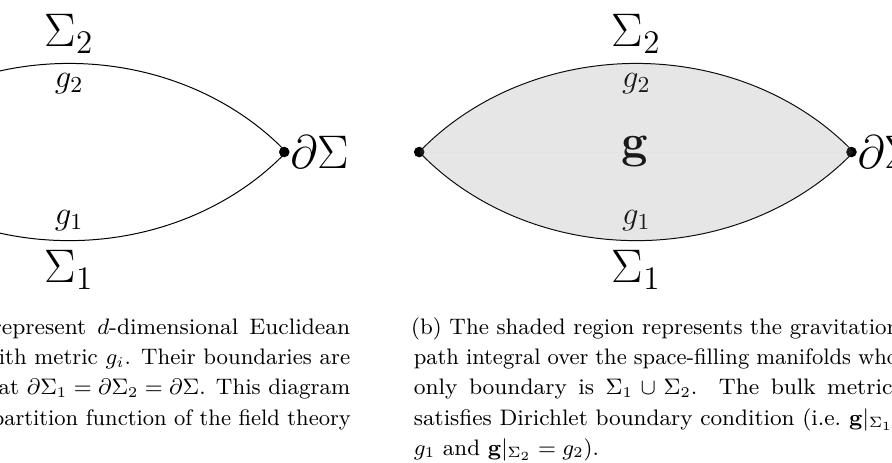
(a) The lines represent d -dimensional Euclidean manifolds Σ i with metric g i . Their boundaries are glued together at ∂ Σ 1 = ∂ Σ 2 = ∂ Σ . This diagram represents the partition function of the field theory on Σ 1 ∪ Σ 2 . Figure 7 . By the GHP, the partition function of the field theory (represented by the hollow figure on the left) is equal to the gravitational path integral (represented by the solid figure on the